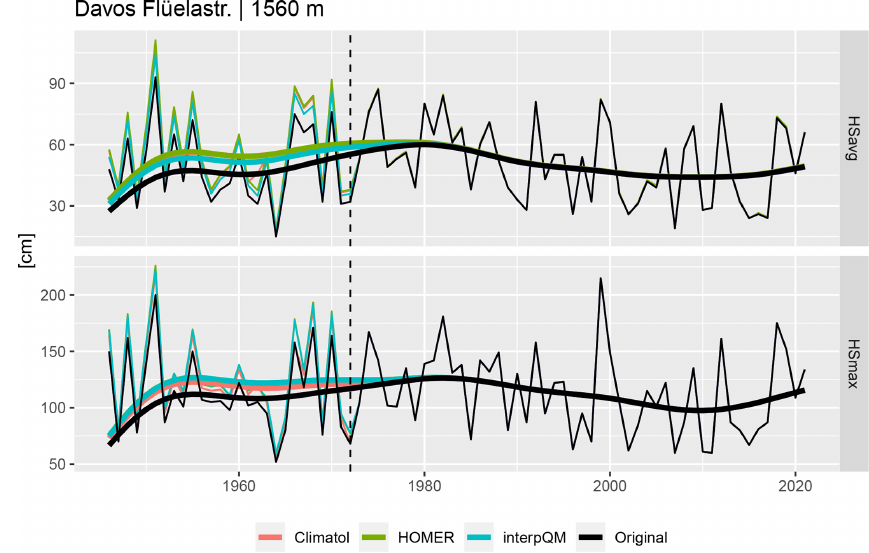
Figure 3. Comparison of original and homogenised seasonal mean (HSavg) and maximum (HSmax) snow depths for the SLF station in Davos. The thick lines show a Gaussian-filtered time series with a 30-year window and the vertical dashed line the identified break in